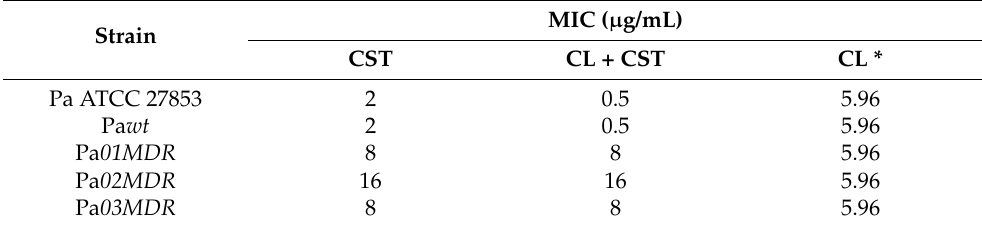
Table 2. Antimicrobial activity (MIC) of CST, CST-free coated nanoliposomes (CL) and CST-coated nanoliposomes (CL + CST) against sensitive and multidrug resistant (MDR) strains of P. aeruginosa.